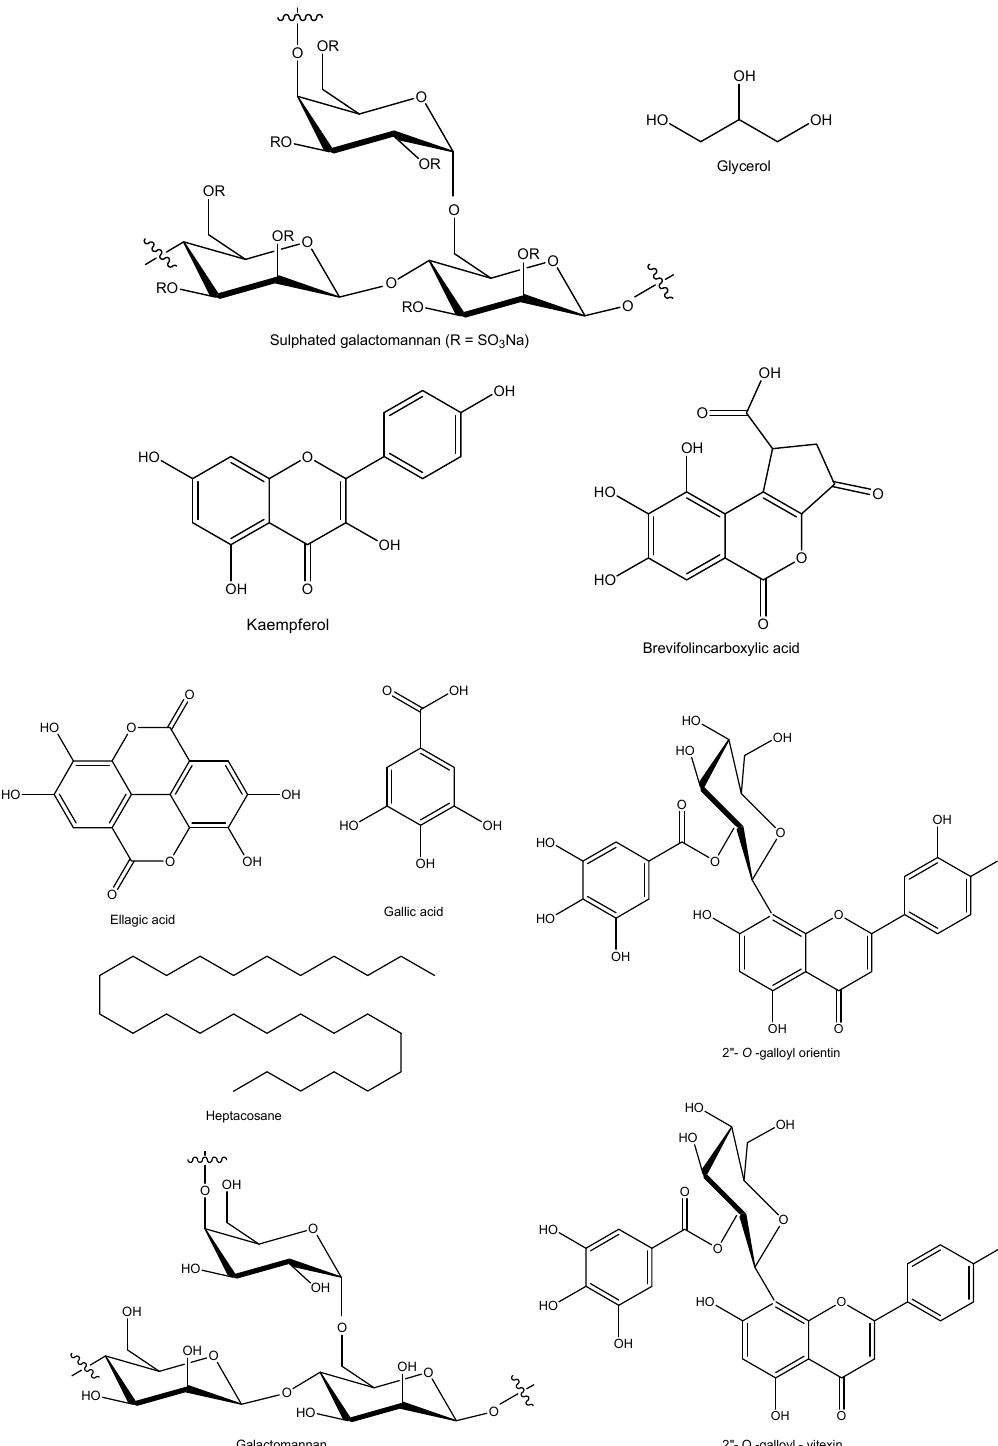
Figure 1. Chemical structures of the main compounds from C. ferrea. Ellagic acid: C 14 H 6 O 8 and MW: 302.19 g/mol; Gallic acid: C 7 H 6 O 5 and MW: 170.12 g/mol; Heptacosan: C 27 H 56 O and MW: 396.7 g/mol; Galactomannan: C 18 H 32 O 16 and MW: 504.4g/mol; Kaempferol: C 15 H 10 O 6 and MW: 286.24 g/mol; 2”- O -Galloylorientin: C 28 H 24 O 15 and MW: 600.5 g/mol; 2”- O -Galloylvitexin: C 28 H 24 O 14 and MW: 584.5 g/mol; Glycerol: C 3 H 8 O 3 and MW: 92.09g/mol.